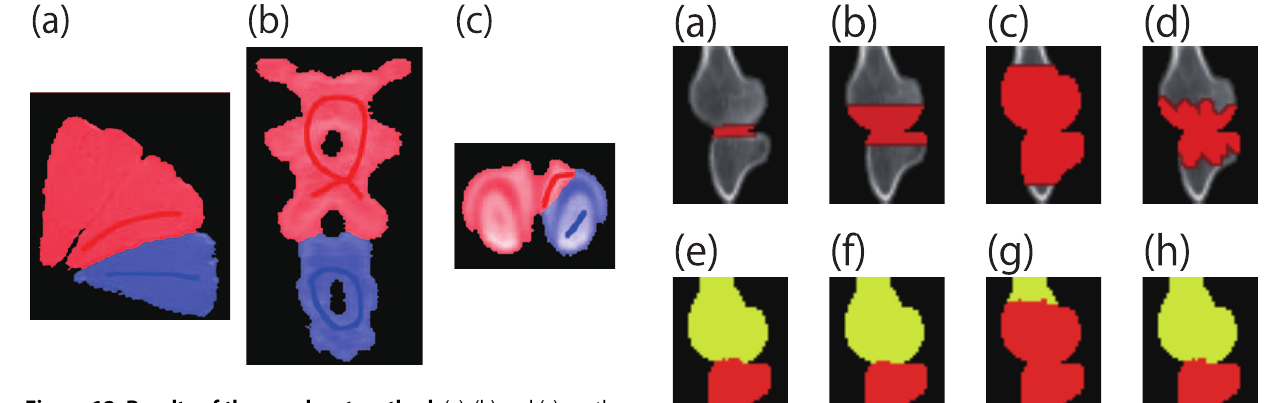
Figure 12. Results of the graph cut method. (a), (b) and (c) are the results of the graph cut method for the images of Fig. 10, Fig. 9, and Fig. 11, respectively. (a) and (b) are considered fine, but (c) is not an appropriate result. Figure 13. Results of ROI test. Images in the top row are input CT images with ROIs (red regions). Images in the bottom row are segmented results for corresponding images in the top